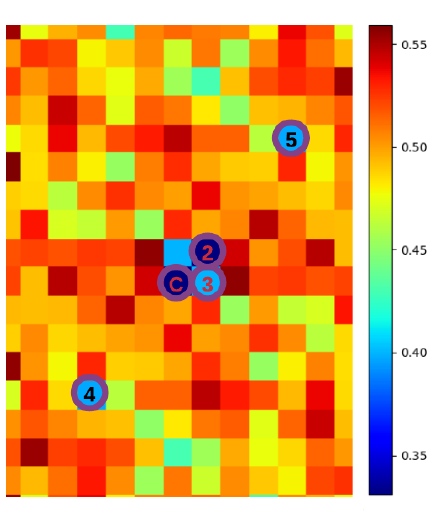
Figure 5. A simple illustration of selecting candidate solutions by skipping the estimates (Estimate 2, 3) that are too close to any picked candidate solution (Estimate